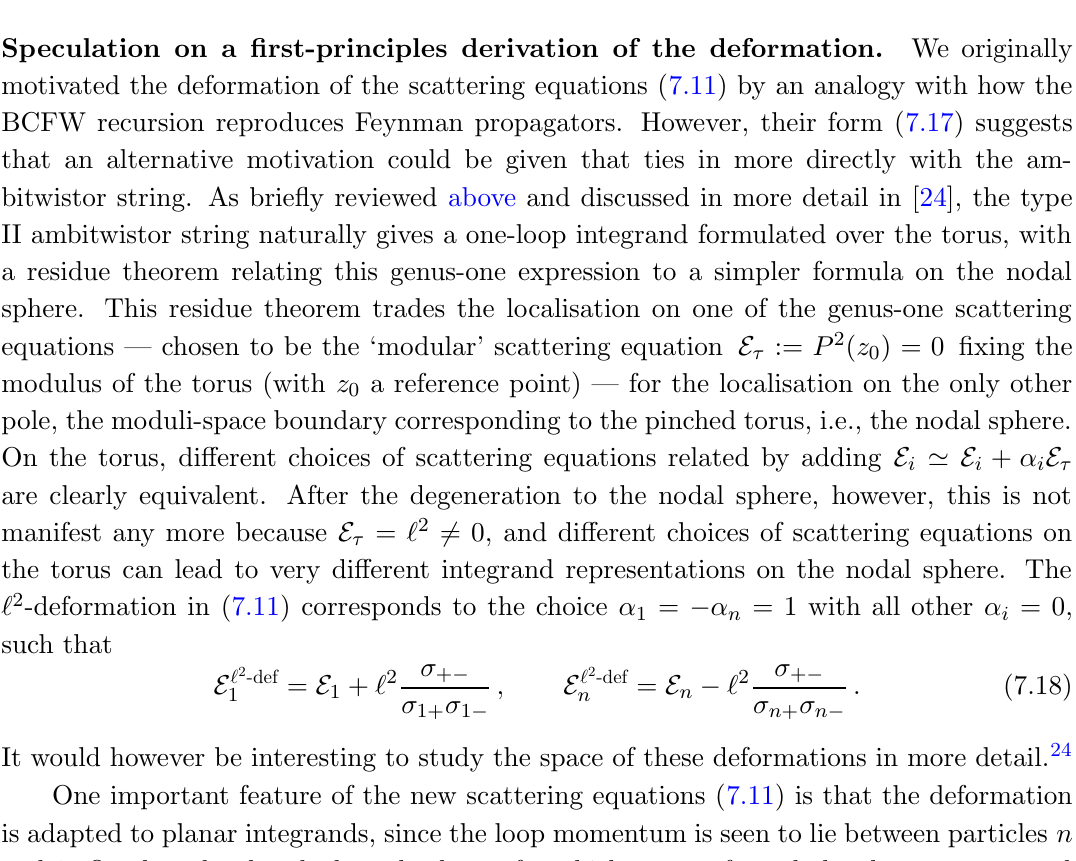
Figure 8 . All singular worldsheet con(cid:12)gurations corresponding to physical poles. The geometry on the left, with + and 1 on one component, and (cid:0) and n on the other, corresponds to a pole at ( ‘ (cid:6) k L ) 2 = 0. The geometries in the middle and on the right correspond to tree-level poles at k 2 = 0, with k L = (cid:0) P k i being the sum over all punctures on the sphere. On the right, we L i 2 L may exchange the roles of 1 and n , but the con(cid:12)guration with both 1 and n on the subsphere leads to unphysical loop